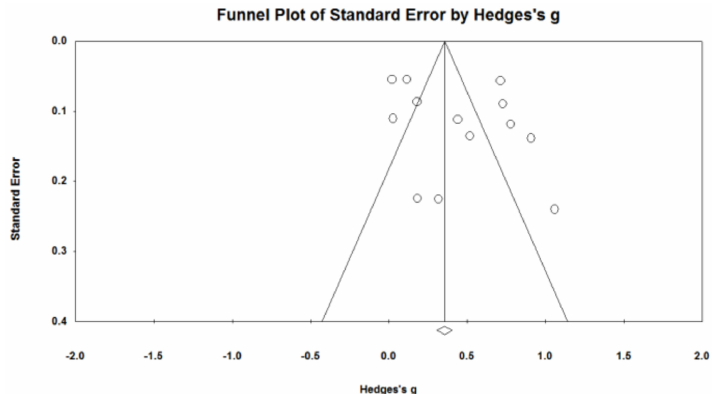
Figure 3. Delay effect Funnel